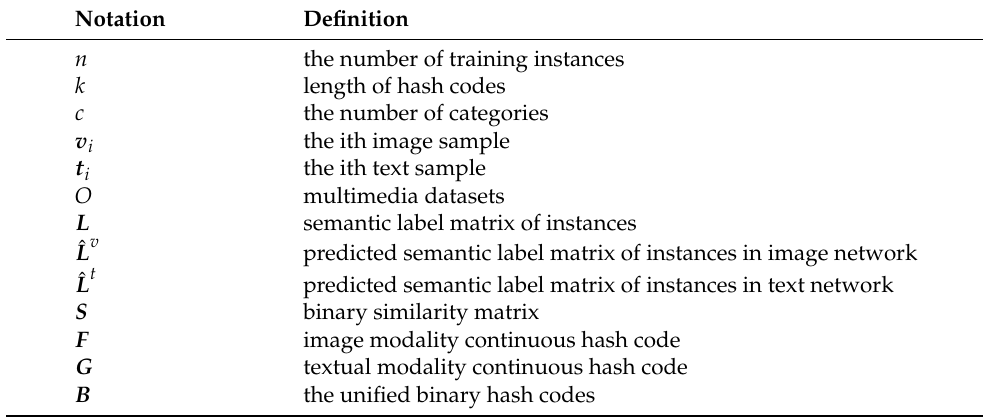
Table 1. A summary of frequently-used